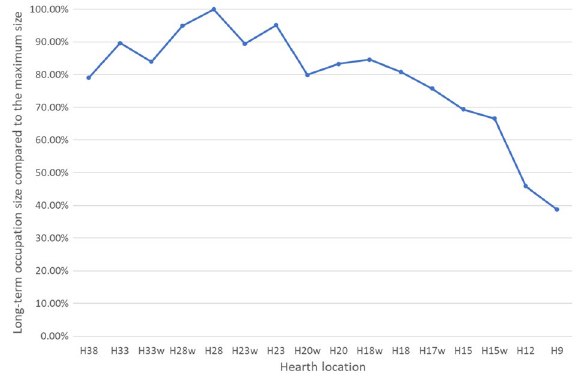
Figure 6. Comparison of the average long-duration occupation area for the three sensor heights, normalized to maximum area size.